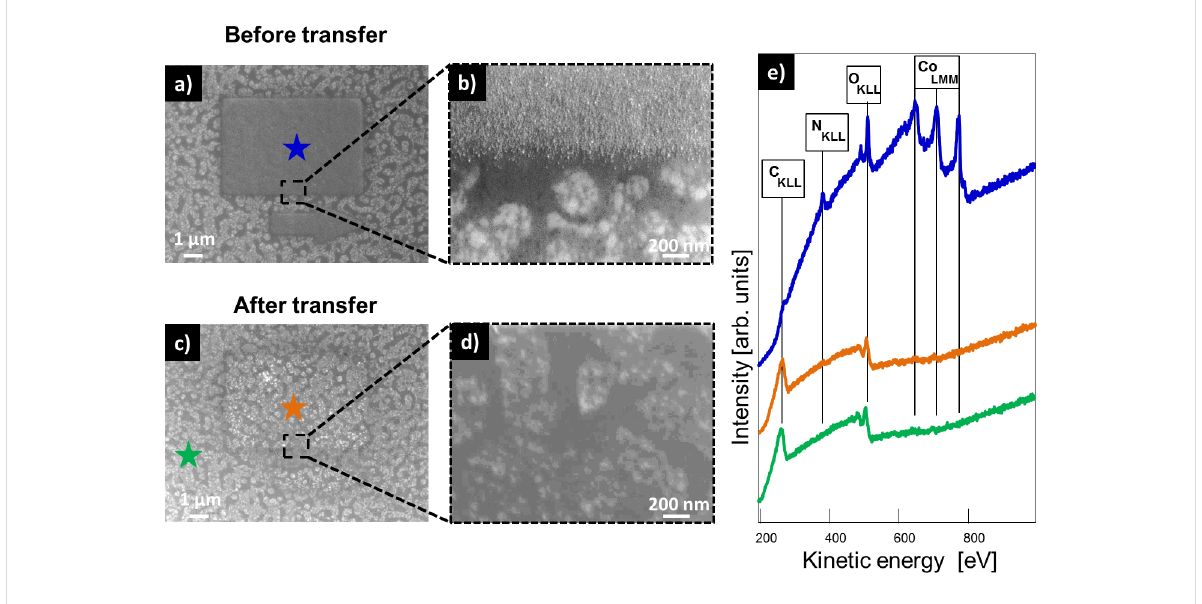
Figure 6: Transfer of a CNM with a cobalt oxide structure on top onto a SiO 2 sample. (a) SEM image of a cobalt oxide structure fabricated with EBID on a TPT SAM on Ag(111)/mica (beam parameters 15 kV, 3 nA, electron dose: 0.93 C/cm 2 , and AG time: 3 h 52 min). (b) Blowup image of the struc- ture depicted in (a). (c) SEM image of the cobalt oxide structure depicted in (a) after the transfer to bulk SiO 2 . (d) Blowup image of the structure depicted in (c). (e) Local AES spectra recorded at the positions indicated with correspondingly colored stars.